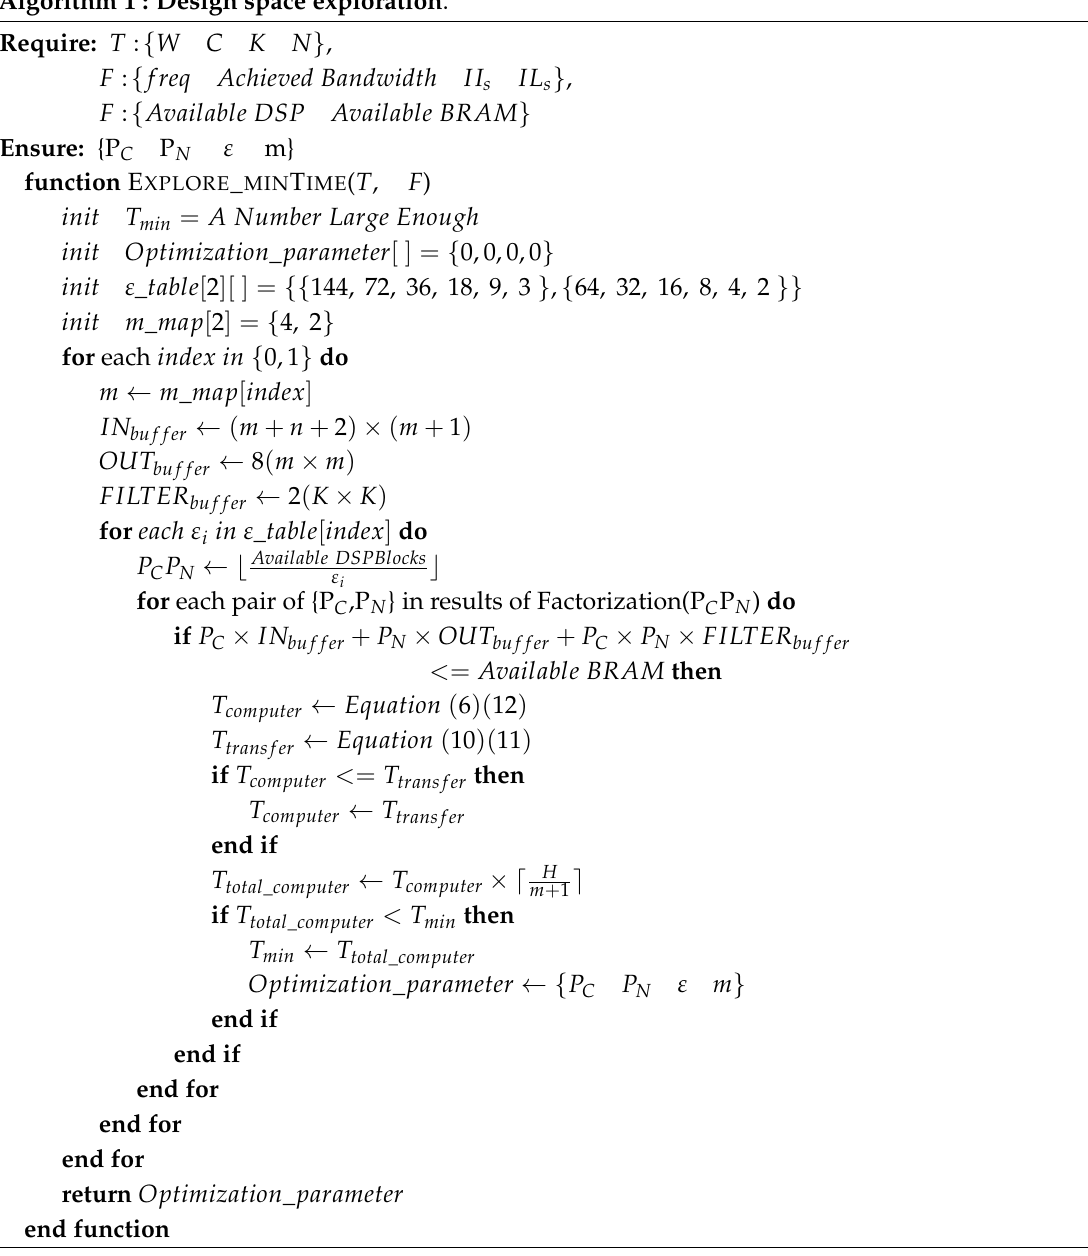
Algorithm 1 : Design space exploration